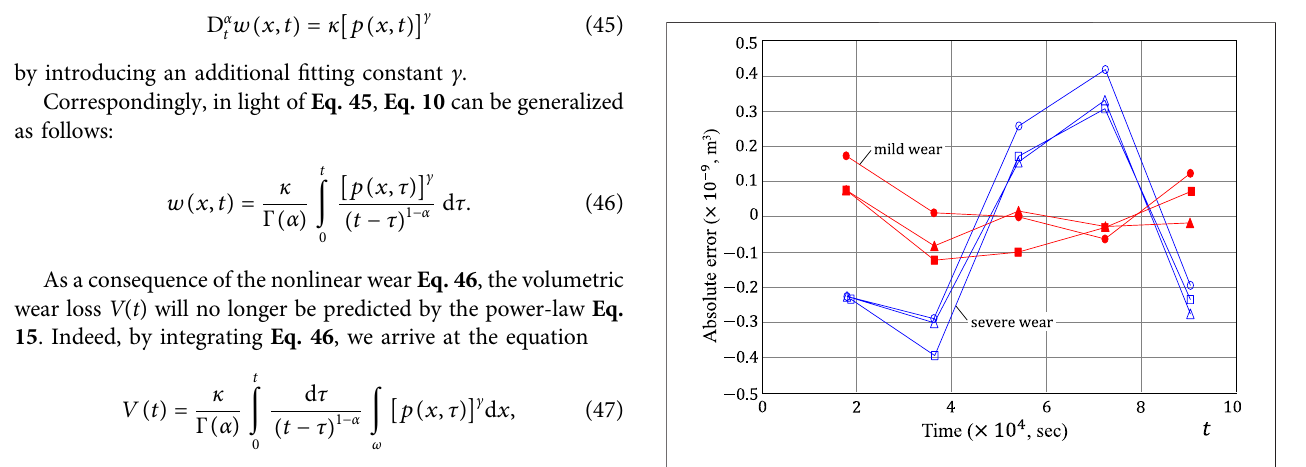
FIGURE 16 | Difference between the power-law predictions and the experimental data(Viswanathand Bellow, 1995) shown in Figure 1 (the same legend